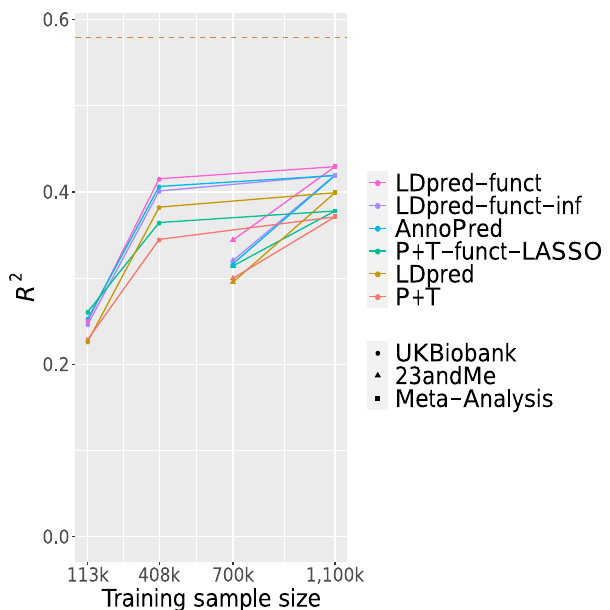
Fig. 4 Accuracy of 6 prediction methods in height meta-analysis of UK Biobank and 23andMe cohorts. We report results for P + T, LDpred, P + T-funct-LASSO, AnnoPred, LDpred-funct-inf, and LDpred-funct, for each of 4 training data sets: UK Biobank interim release (113,660 training samples), UK Biobank (408,092 training samples), 23andMe (698,430 training samples) and meta-analysis of UK Biobank and 23andMe (1,107,430 training samples). Nested training data sets are connected by solid lines (e.g. UK Biobank (408 k) and 23andMe are both connected to Meta- Analysis, but not to each other). The dashed line denotes the estimate of SNP-heritability in the UK Biobank. Numerical results are reported in Supplementary Table 27. Block-Jackknife standard errors over 200 genomic jackknife blocks were < 0.028 across each method. Source data are provided as a Source Data fi